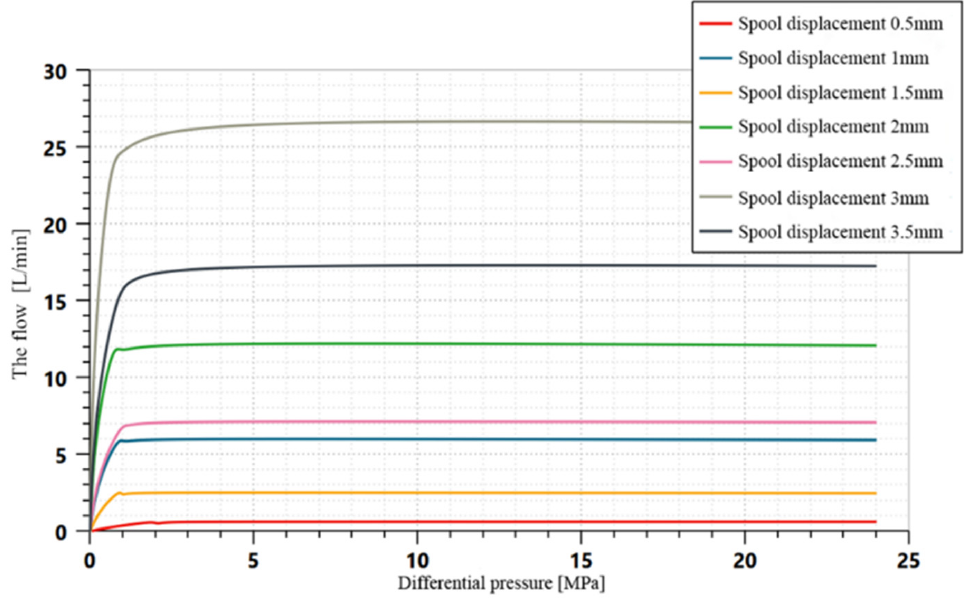
Figure 20. Differential pressure–flow rate characteristic curve.